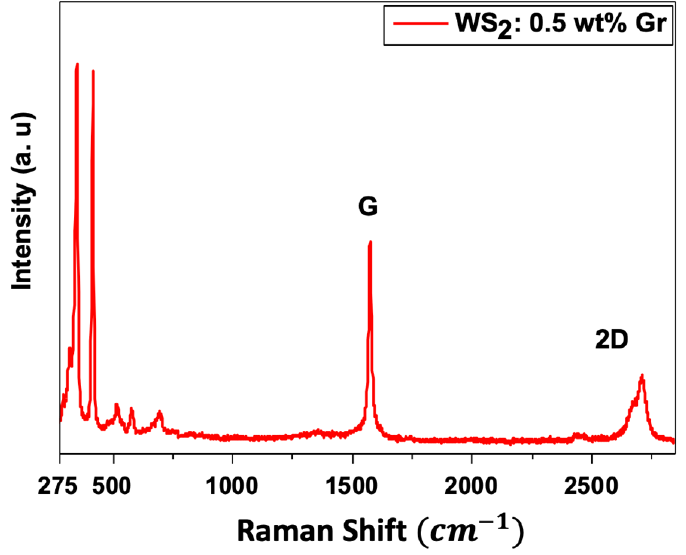
Figure 5. Raman spectra for graphene@WS 2 samples. Typical G-band and 2D-band vibrational modes of graphene are recorded.